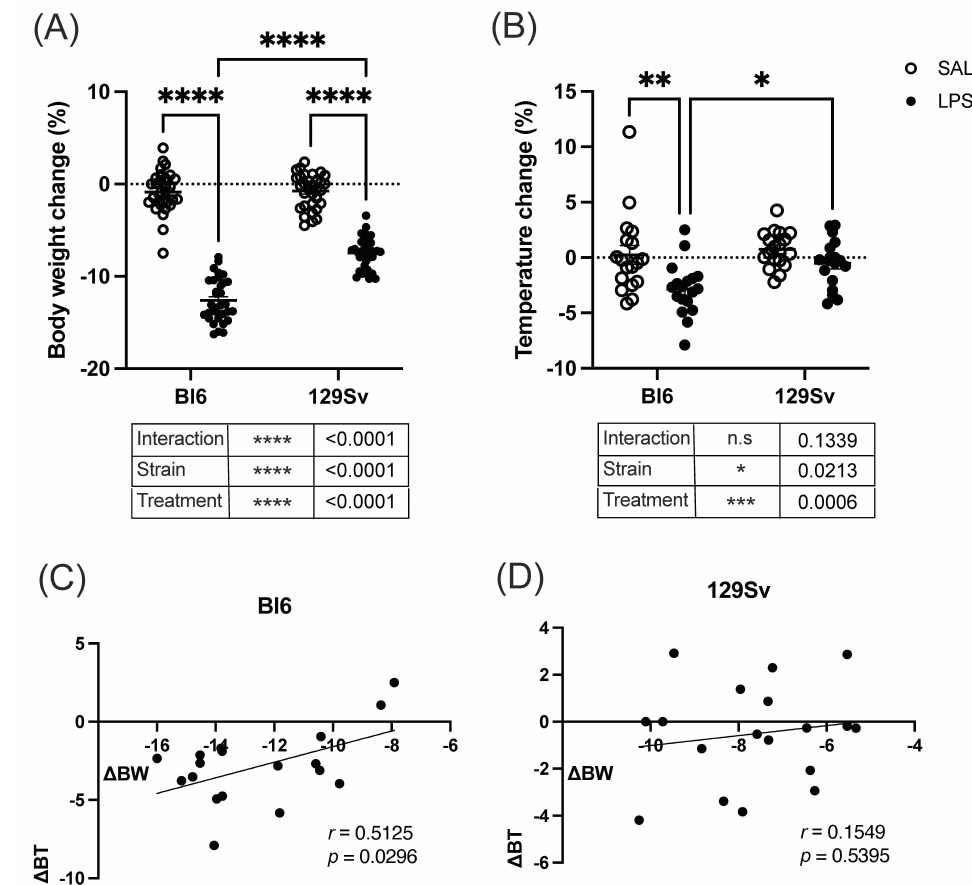
Figure 2. LPS-induced bodyweight and temperature alterations. The bodyweight and temperature of Bl6 and 129Sv mice was measured before and after 24 h of LPS (0.5 mg/kg, i.p) and saline administration. ( A ) Bodyweight change (%). ( B ) Body temperature change (%). Pearson correlation between bodyweight ( ∆ BW) and body temperature change ( ∆ BT) in Bl6 ( C ) and 129Sv ( D ) mice. Data are expressed as mean values ± SEM: n.s. > 0.05, * p ≤ 0.05, ** p ≤ 0.01, *** p ≤ 0.001, **** p ≤